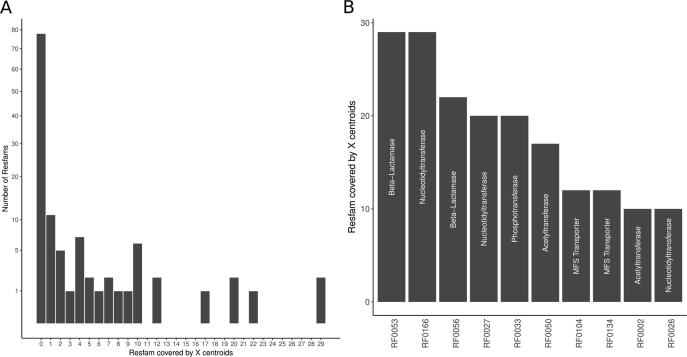
Resfams covered by centroids associated with resistance Number of centroids covering Resfams considering only centroids with a significant resistance association. A. Histogram of the centroid counts; the values on Y axis is square root transformed. B. The top 10 Resfams with their mechanism class and the number of centroids covering them.